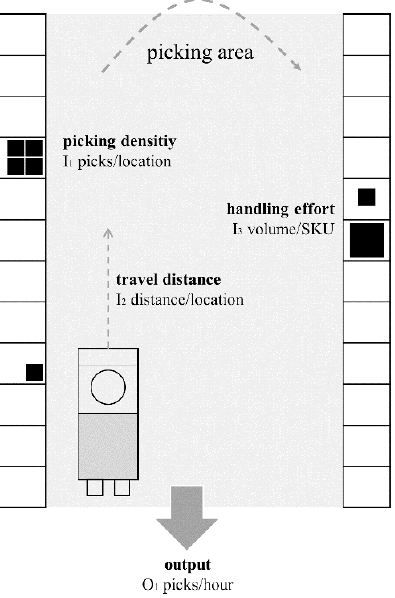
Table 1. Attributes of the dataset and correlation matrix for applied input and output measure- ments.